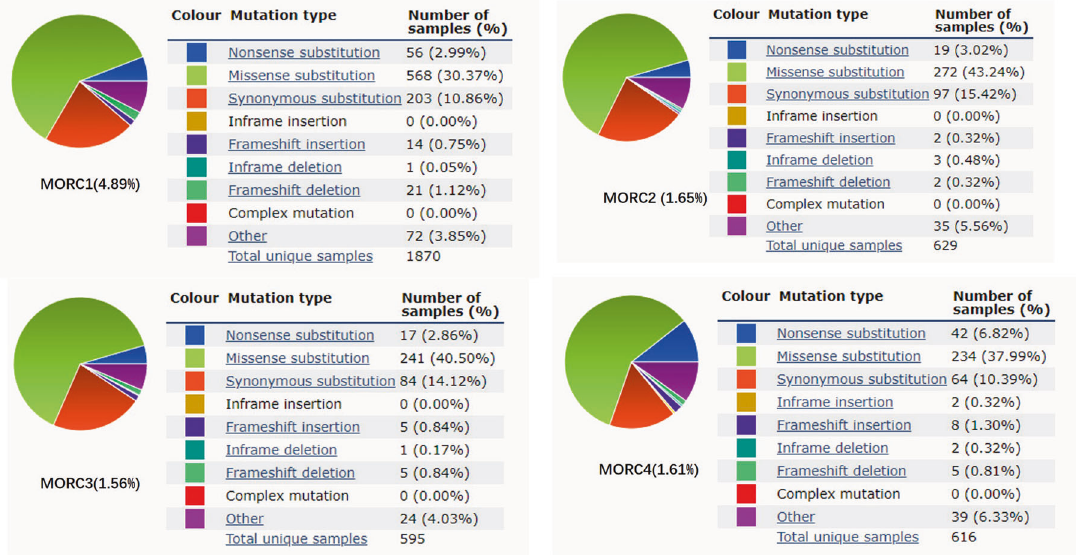
Fig. 5 An overview of the types of MORC family mutation observed. According to the Cosmic public databases (https://cancer.sanger.ac.uk/ cosmic), these charts show a summary of the types of mutation that have been observed in samples for MORCs gene. These tables show the number of samples recorded as having a particular type of mutation, with the number in brackets giving the percentage of samples with that type of mutation. Meanwhile, note that a sample may have more than one type of mutation, so the total number of samples determined by simply summing the values in the table may not match the total number of unique samples given under the table. For the same reason, summing the percentages in the table may give a value of greater than